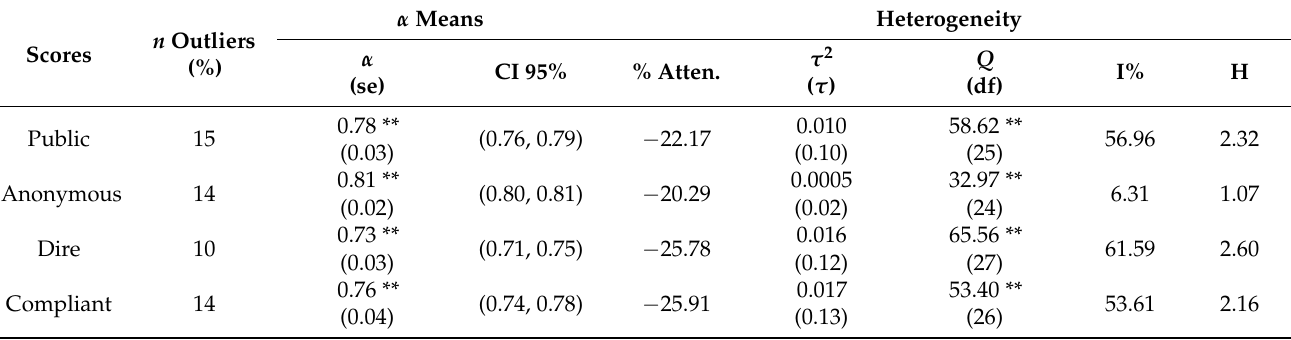
Table 5. Robust estimates (without outliers) for PTM